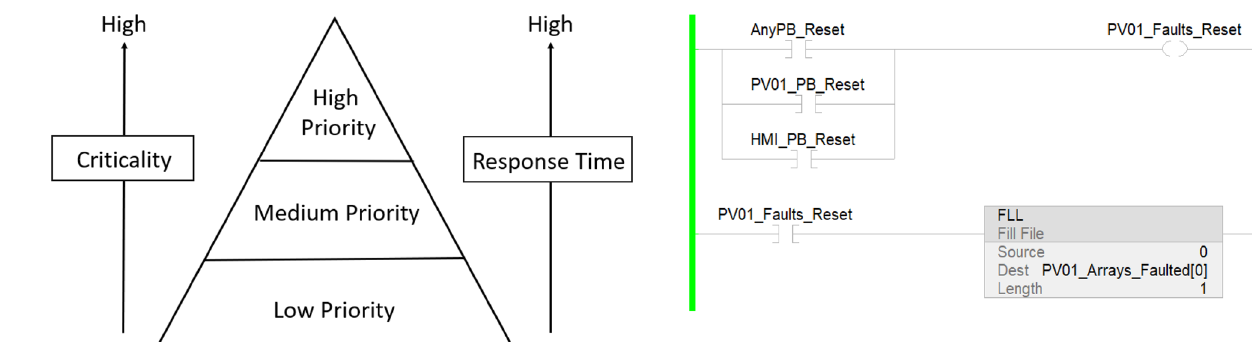
Fig. 3 Faults reset setup to clear non-retentive alarms